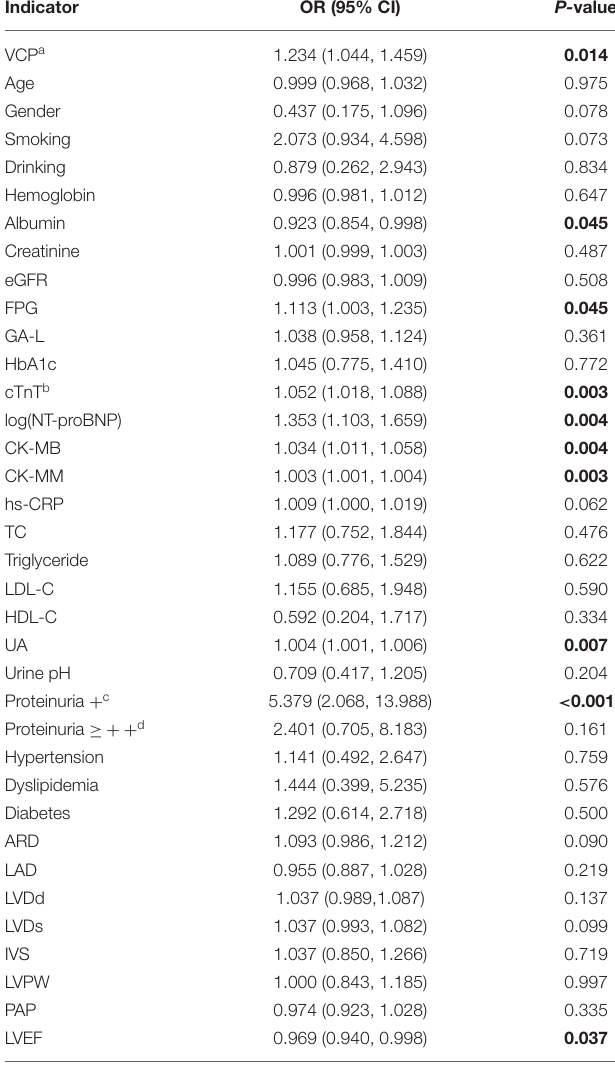
TABLE 3 | Univariate logistic regression analysis of ACS and possible indicators (all indicators increase by 1 unit unless otherwise specified). Indicator